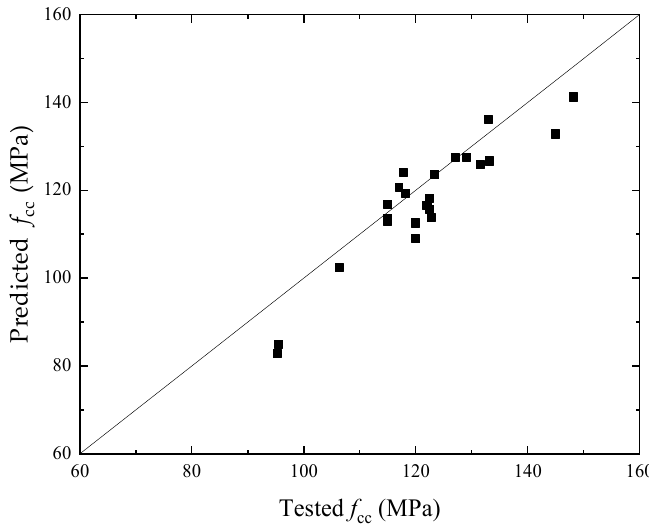
Figure 19. Comparison of model calculated f cc with tested f cc